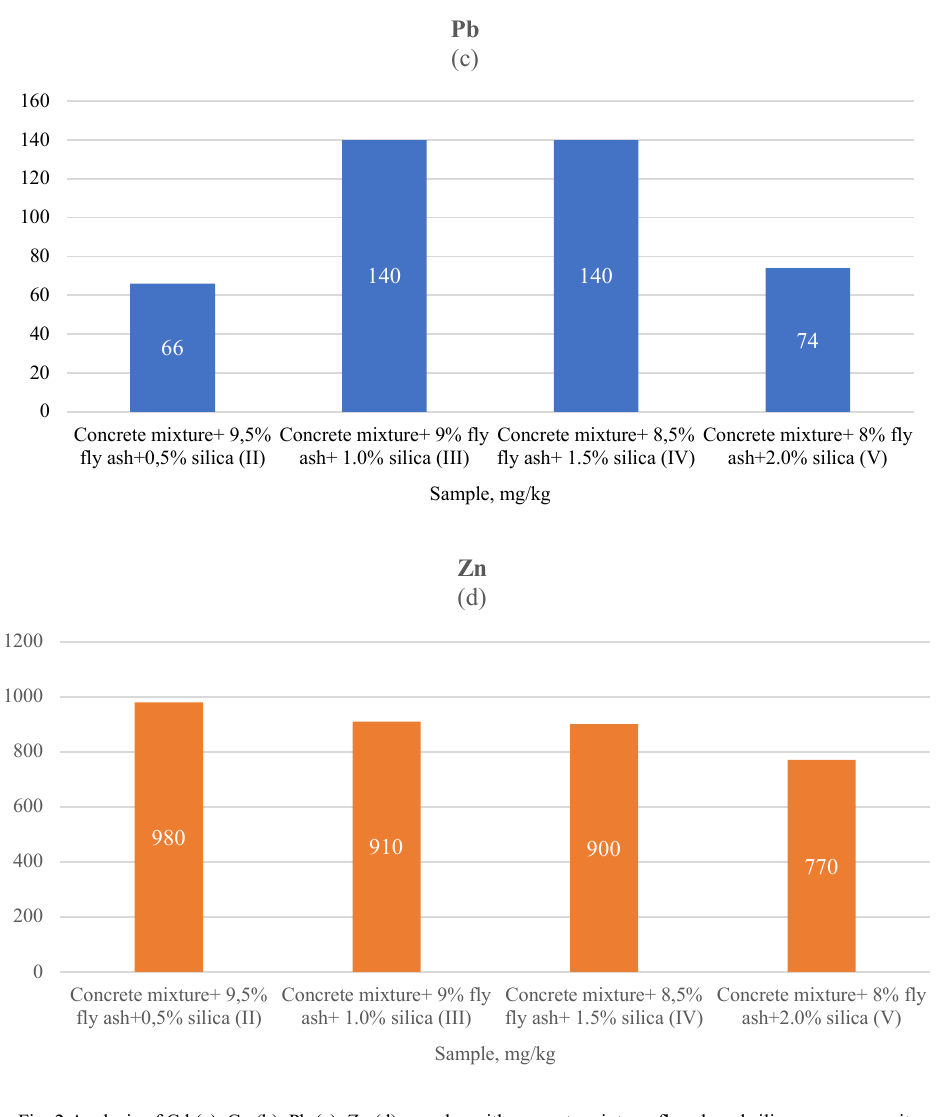
Fig. 2 Analysis of Cd (a), Cu (b), Pb (c), Zn (d) samples with concrete mixture, fly ash and silica